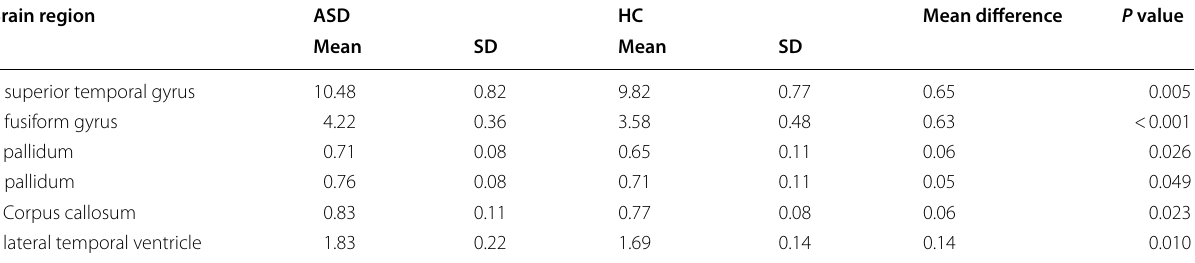
Table 5 Statistical results of gray matter in Hammers Atlas (significant differences) Brain region